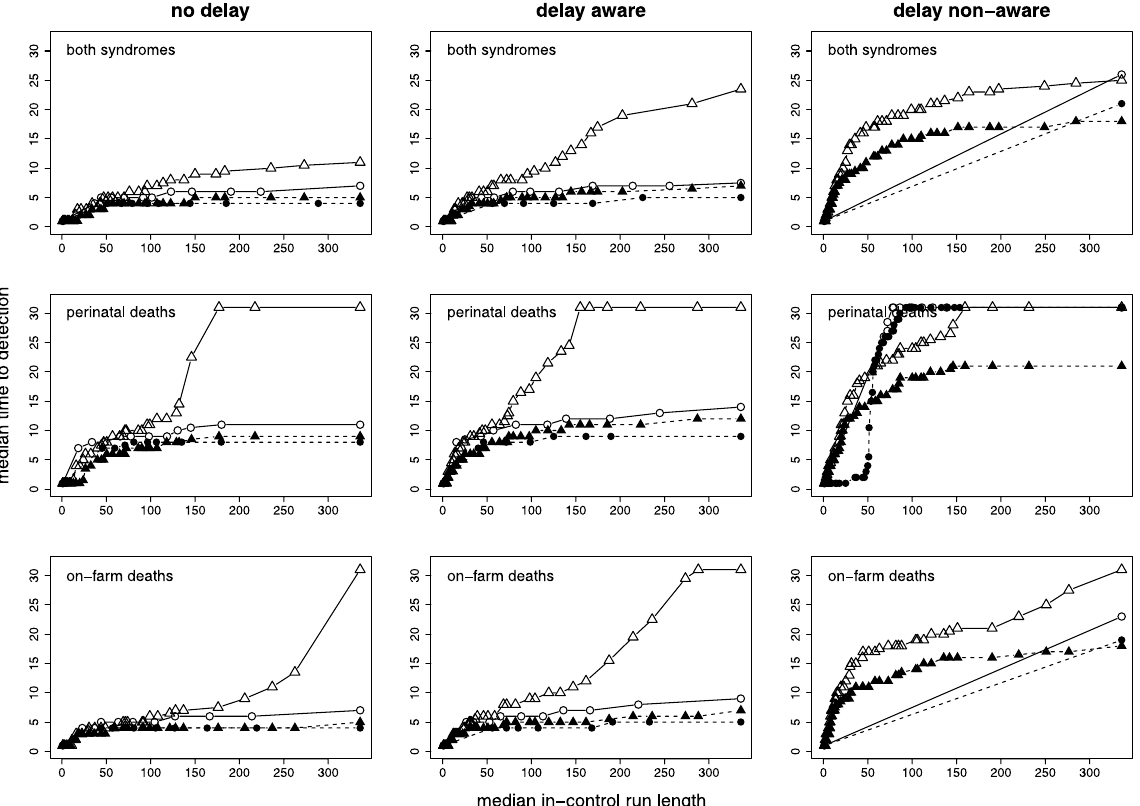
Figure 6. Median time to detection and in-control run length for a range of alarm thresholds based on the value of evidence (circles) and the z-score (triangles), summarised for the smaller (empty symbols with solid lines) and larger (filled symbols with dashed lines) outbreak type. Values in the bottom right corner of the graph tend towards an ideal system with a time to detection = 0 (i.e. an outbreak is detected on the day it starts) and run length = 336 days (i.e. no false alarm occurs within 1 year).